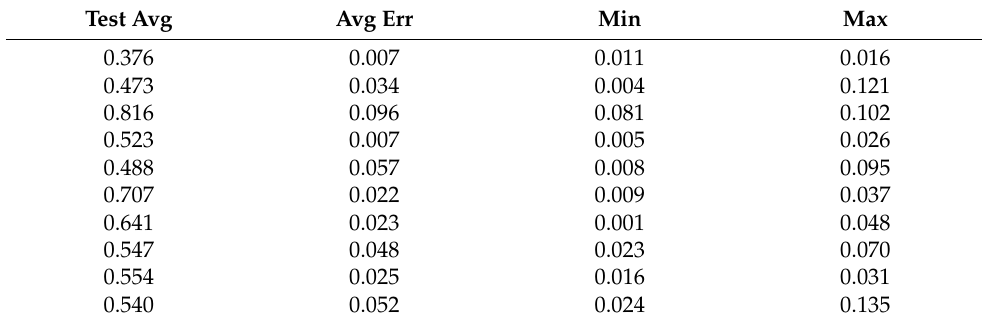
Table A162. Set 3, trials 1–10 data (actual PR value).